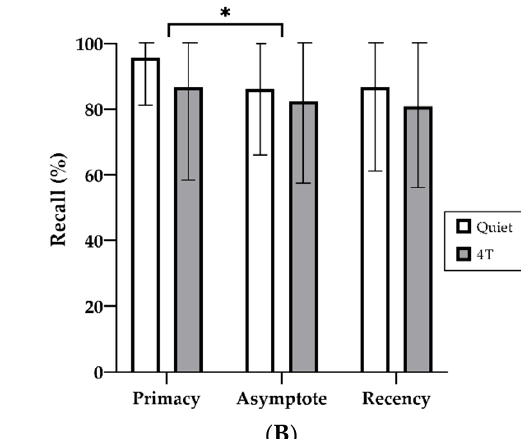
Figure 4. Scatterplots of recall performance versus reading span (RS) scores. ( A ) in stationary noise ( N = 25); ( B ) in the quiet condition (dashed line) and four-talker babble noise (solid line) ( N = 34).